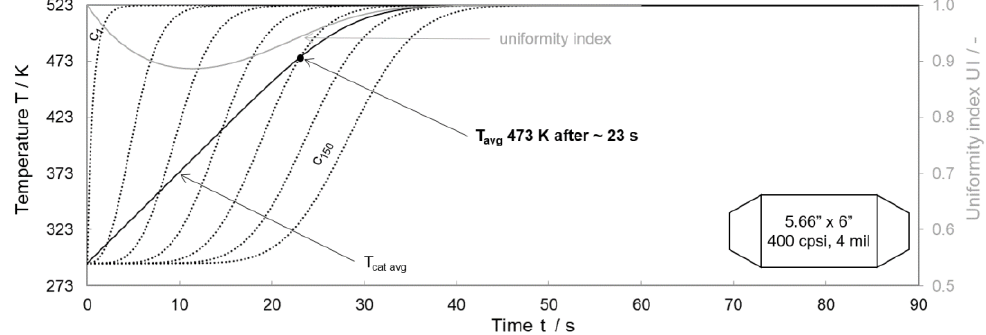
Figure A1. Heat-up of 400 cpsi, 4 mil (reference) at steady state heat-up.